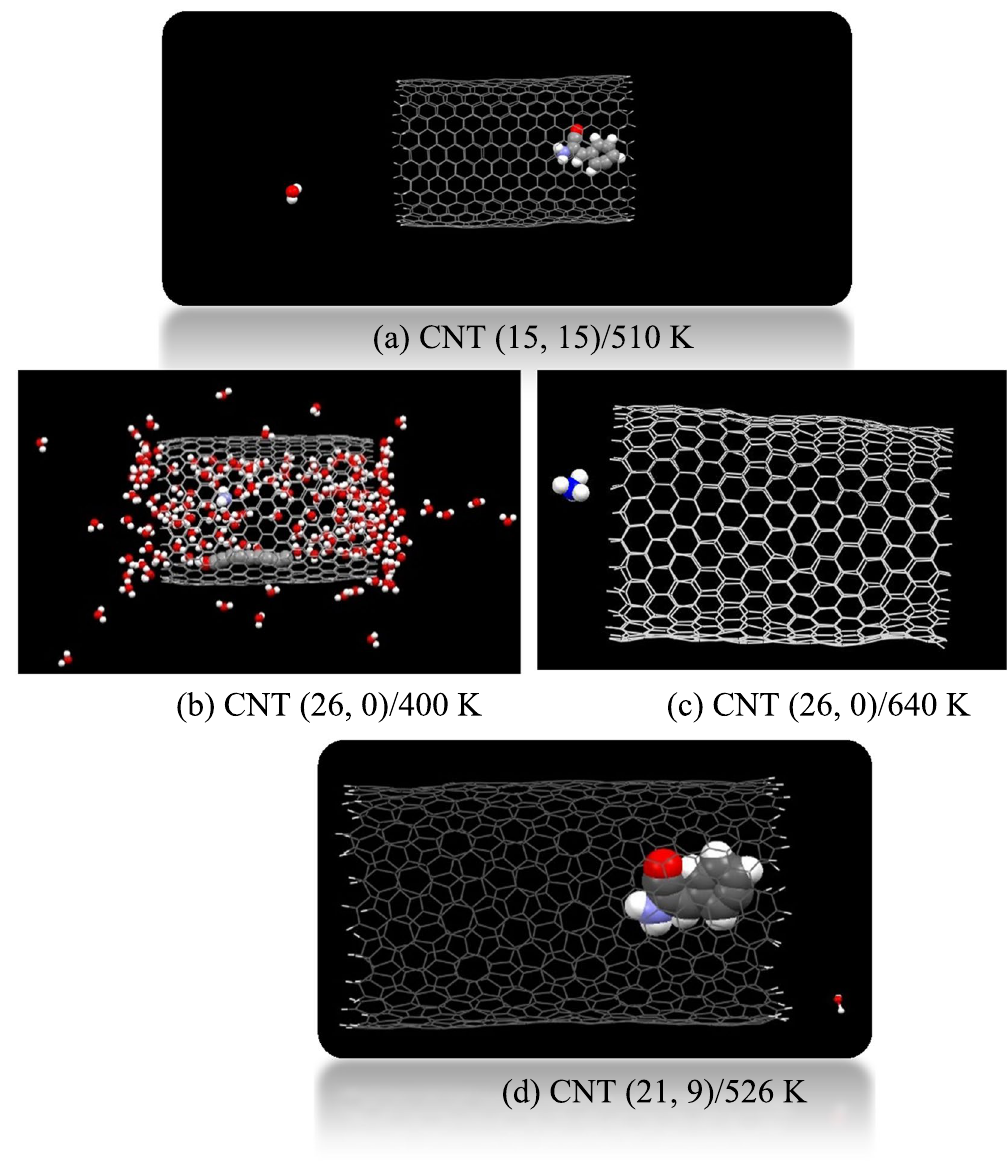
Figure 2. The release process of molecules confined in ( a ) CNT (15, 15) at the temperature of 510 K, ( b ) CNT (26, 0) at temperature 400 K, ( c ) CNT (26, 0) at temperature 640 K and ( d ) CNT (21, 9) at temperature 526